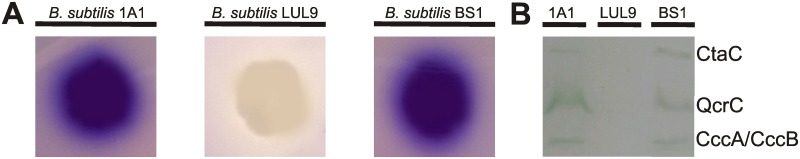
HP0377 restores wild type phenotype in Bacillus subtilis ΔresA strain.(A) TMPD staining of bacterial colonies; a dark pigmentation indicates cytochrome c oxidase activity. Strain 1A1 is a wild-type B. subtilis, LUL9 is a ResA-deficient strain, BS1 is a derivative of LUL9 harboring wild-type hp0377 integrated at the amyE locus, (B) SDS/PAGE examination of B. subtilis membranes stained for covalently bound heme. Cytochromes indicated are CtaC (subunit II of cytochrome caa3), QcrC (subunit c of the cytochrome bc complex) and CccA/B (cytochrome c550 and cytochrome c551 which are not resolved).